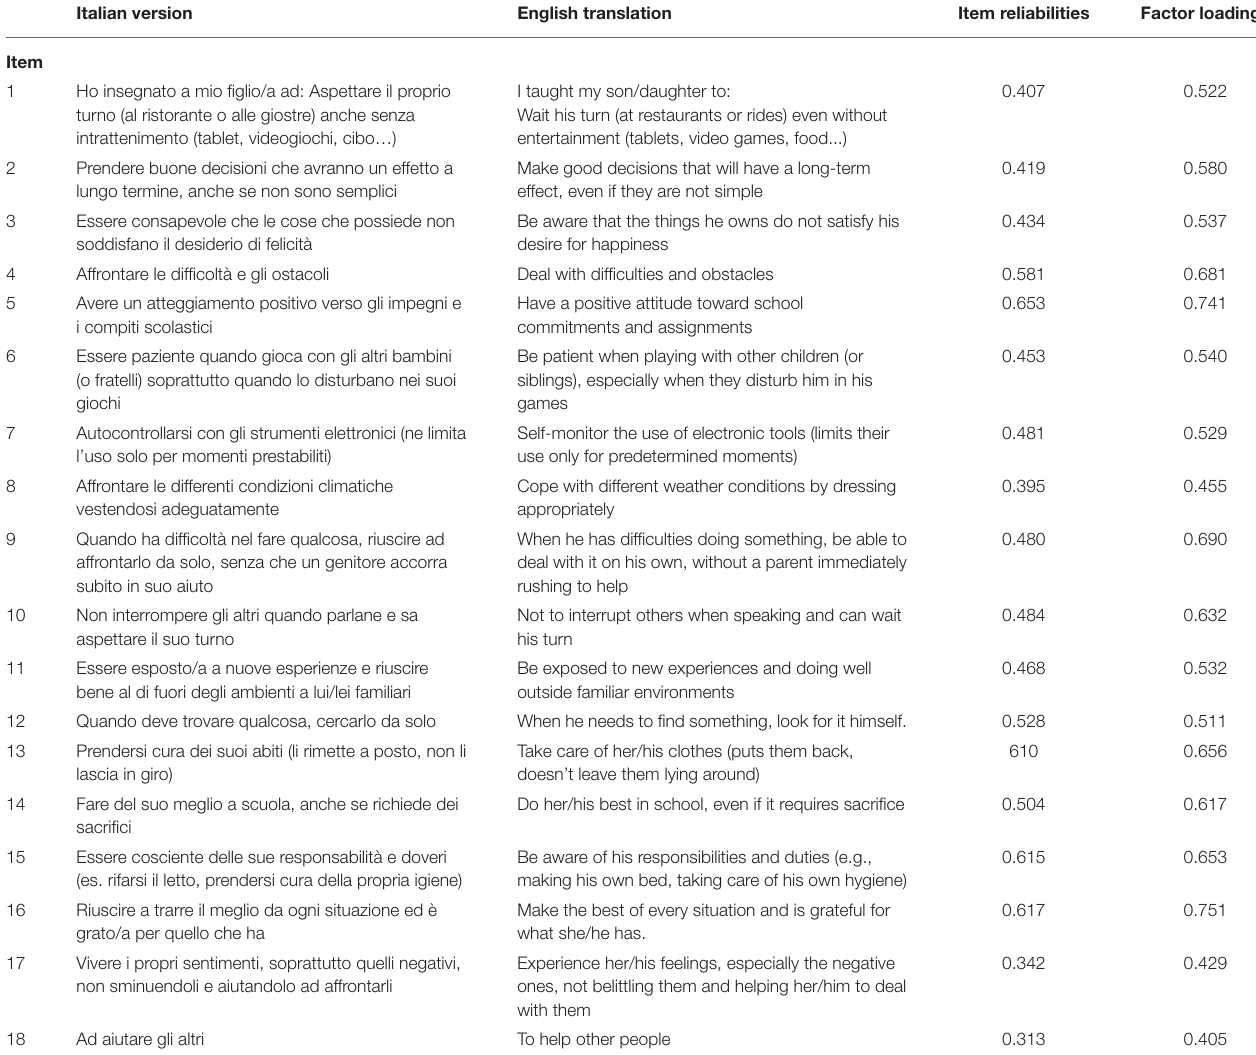
TABLE 3 | COPEWithMe items (Italian and English version) and EFA factor loadings. Italian